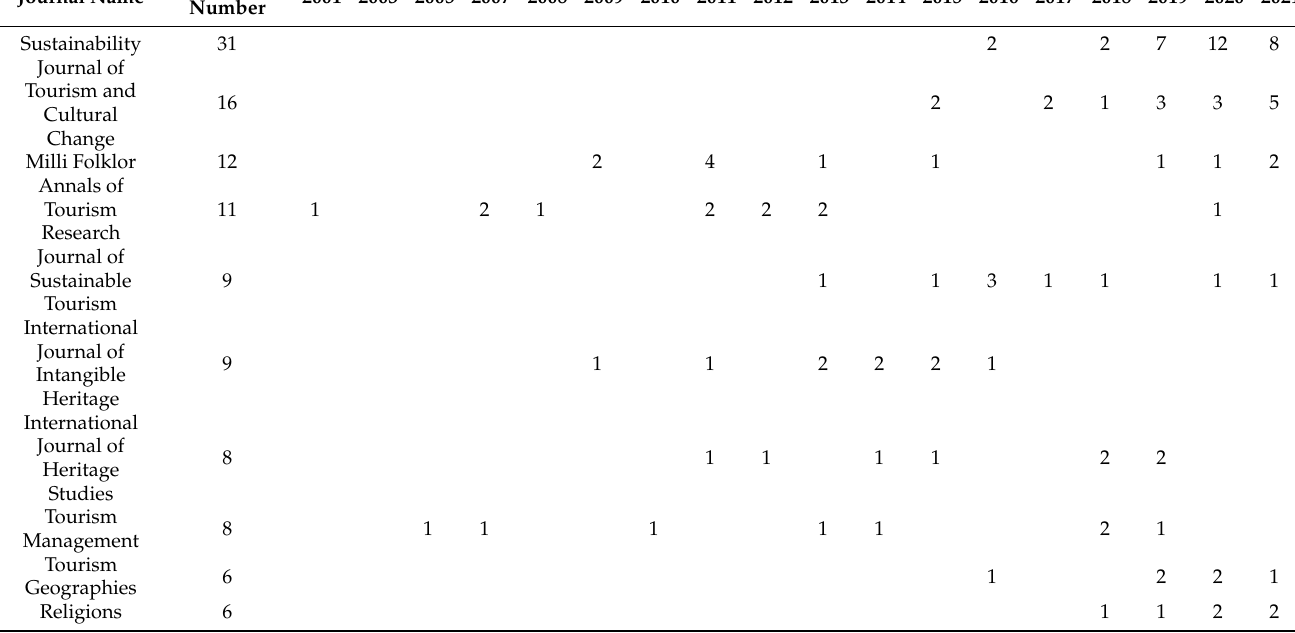
Table 1. Top 10 journals ordered by articles